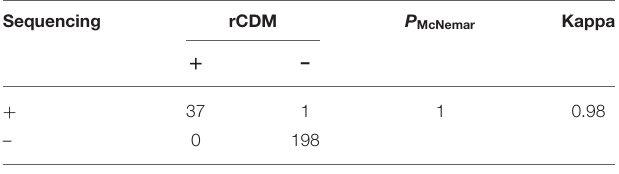
TABLE 6 | The statistic results of sequencing and rCDM for 236 P. aeruginosa isolates.